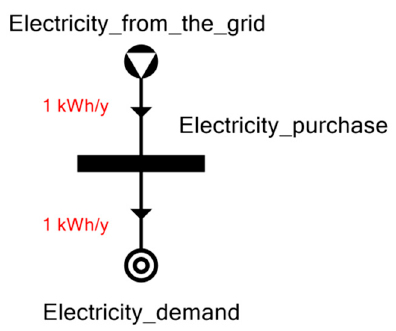
Figure 3. Electricity purchase in the P-Graph model.